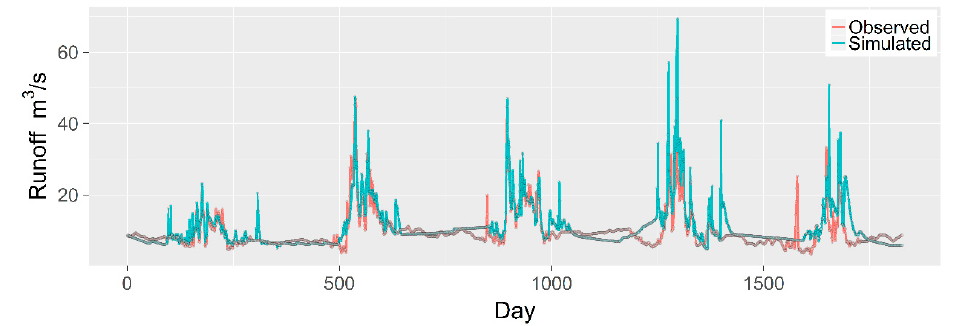
Figure 9. Daily runoff (2009–2013) of Hot Spring station derived from the SWAT model driven by the CMADS.